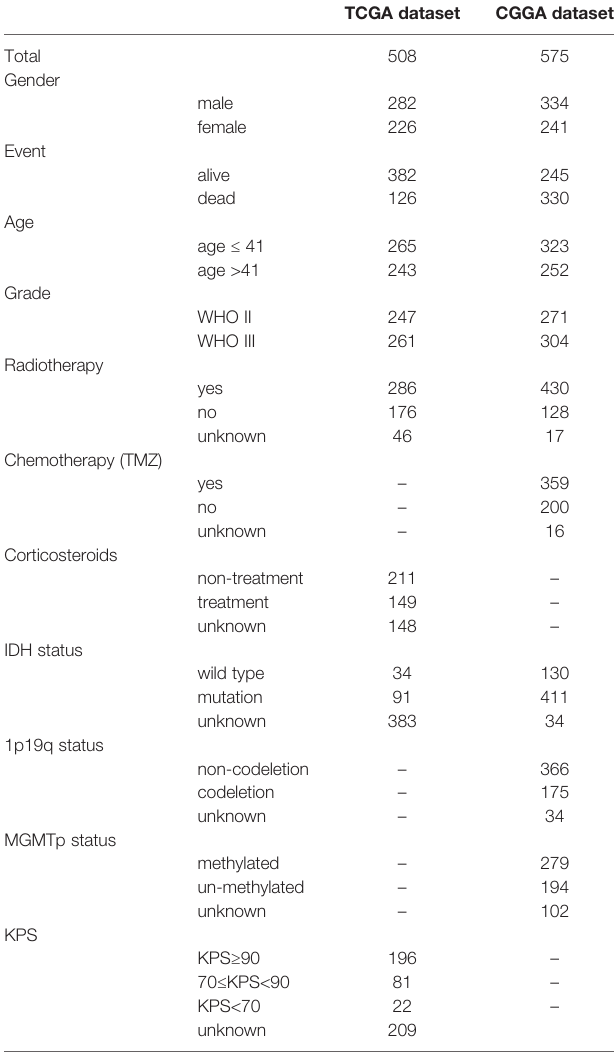
TABLE 1 | Demographic and clinicopathologic characteristics of the LGG patients enrolled in this